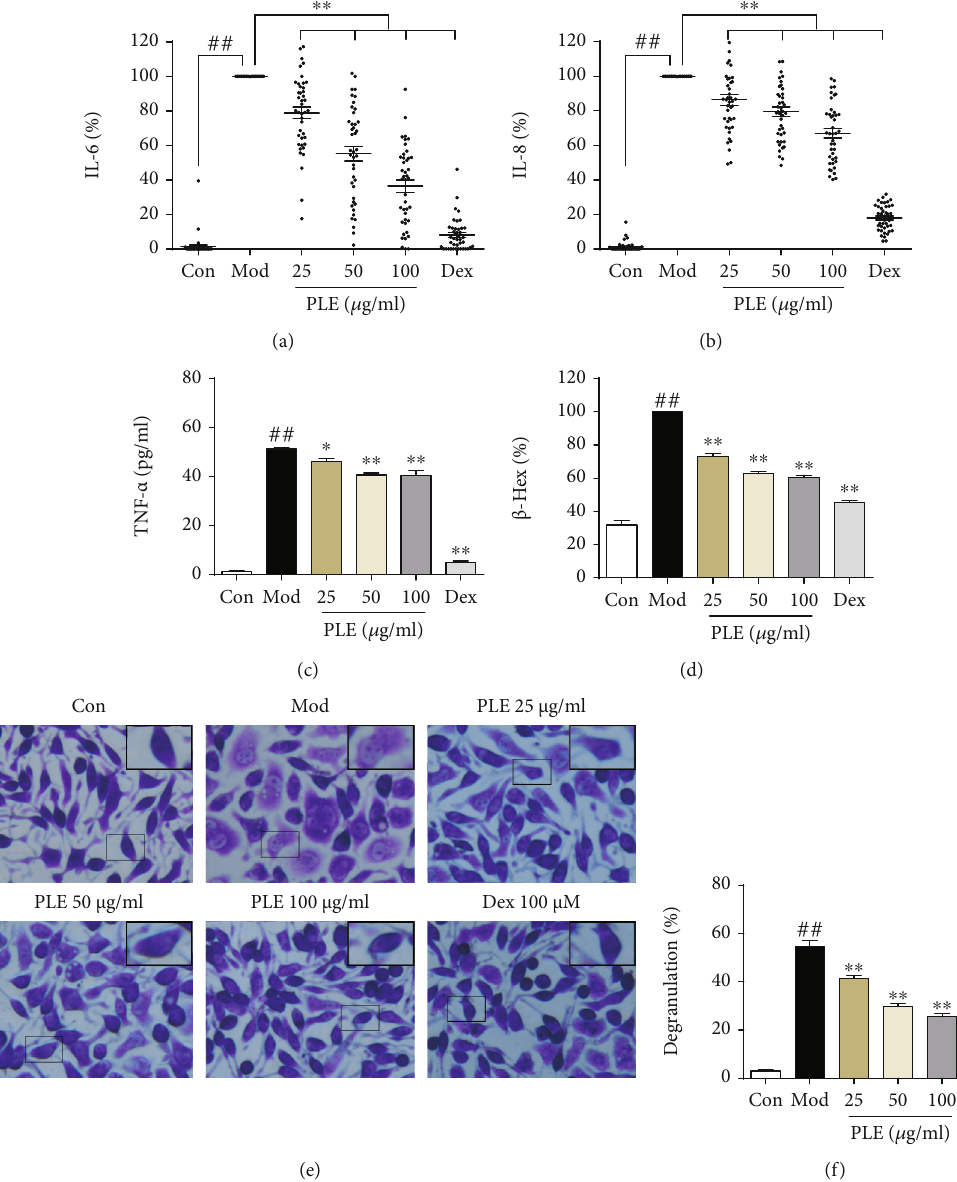
Figure 2: PLE exerted anti-in fl ammation e ff ect in allergic asthma in vitro . (a, b) The levels of IL-6 and IL-8 production (%) in OVA-induced human PBMCs ( n = 42 ). (c) The concentrations of TNF- α in DNP-IgE/BSA-induced RBL-2H3 cells ( n = 3 independent experiments) measured by ELISA. (d) The level of β -Hex (%) in DNP-IgE/BSA-induced RBL-2H3 cells ( n = 3 independent experiments). (e) Images of RBL-2H3 cells stained by toluidine blue (magni fi cation, × 400) with (f) its degranulation rate (%) ( n = 3 ). ## P < 0 : 01 vs. the control group; ∗ P < 0 : 05 and ∗∗ P < 0 : 01 vs. the model